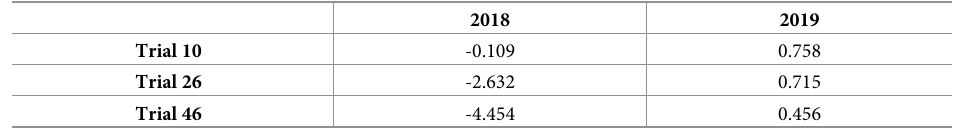
Table 4. R 2 of the 2018 and 2019 predictions a .